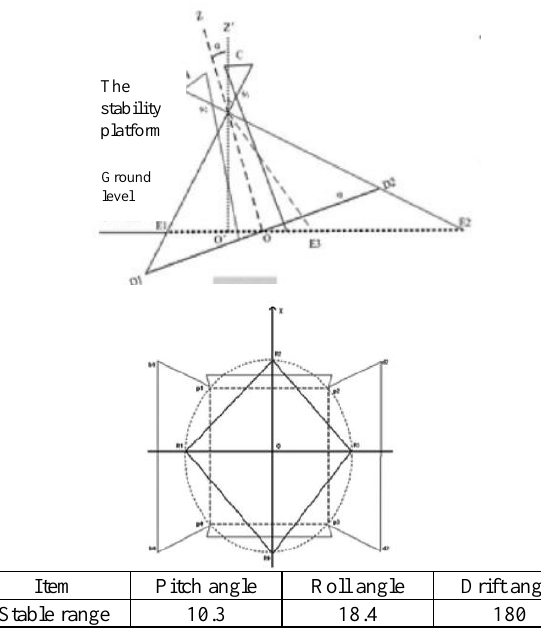
Figure 13. The images cutting of the stability platform